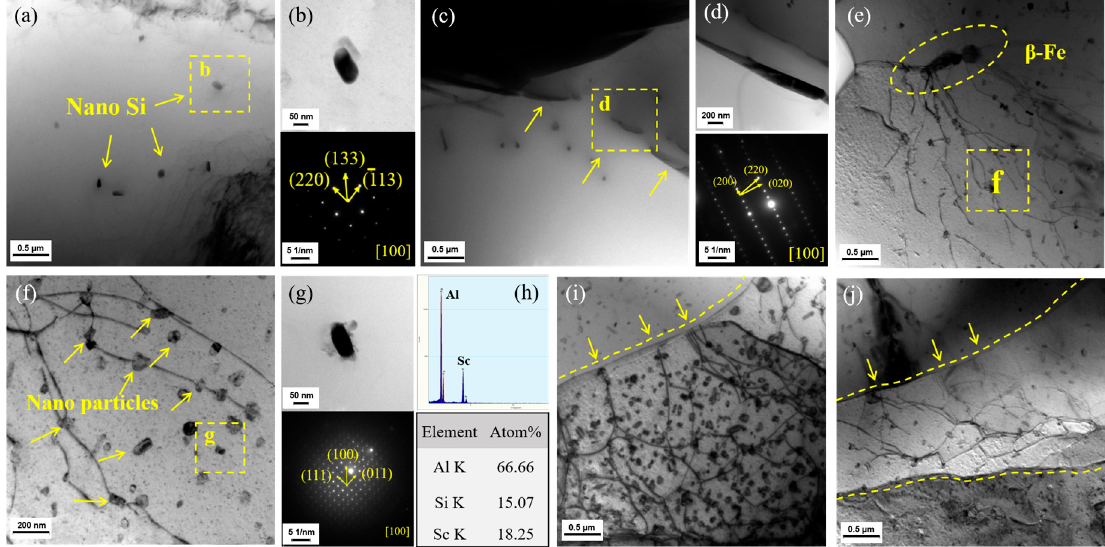
Figure 4. TEM photographs and phase determination of the specimens tested at different temperatures: ( a , b ) − 60 °C, ( c , d ) 20 °C, ( e – j ) 200